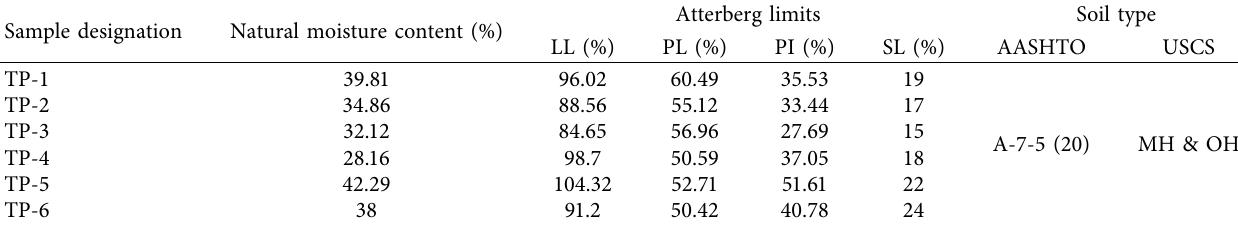
Table 4: Atterberg limit test results of the raw expansive soil for each test